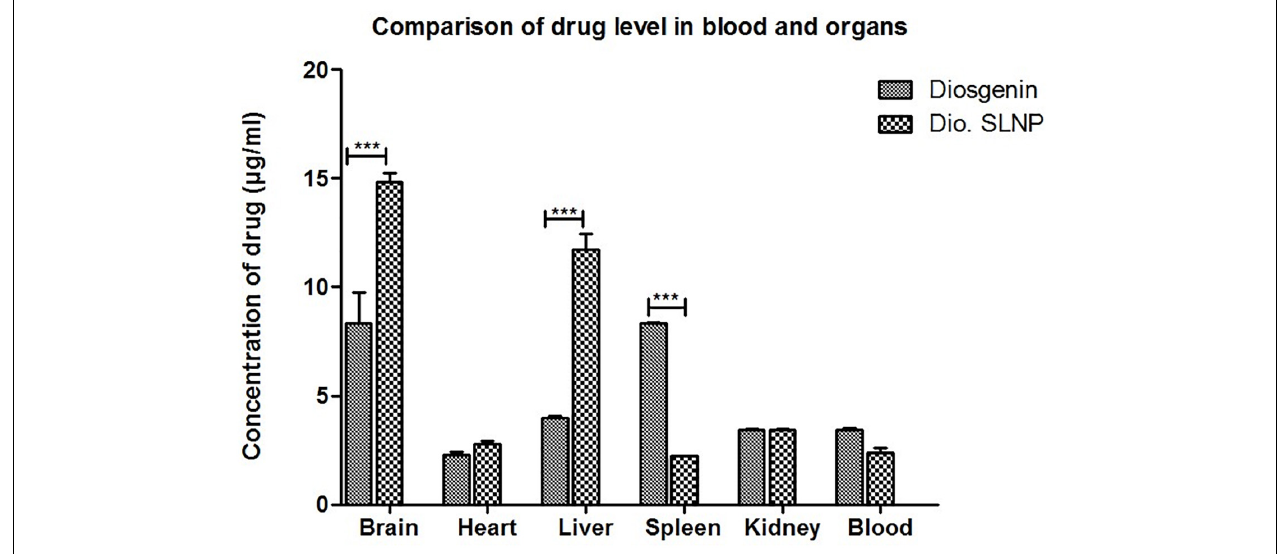
FIGURE 9 | Concentrations of diosgenin level in brain, heart, liver, spleen, kidney, and blood, which was administered intraperitoneally (5 mg/kg in saline 10 ml/kg body weight). Comparison shows a significant difference of diosgenin level in brain, liver, and spleen when administered alone and when encapsulated in solid lipid nanoparticles. *** p < 0.001.